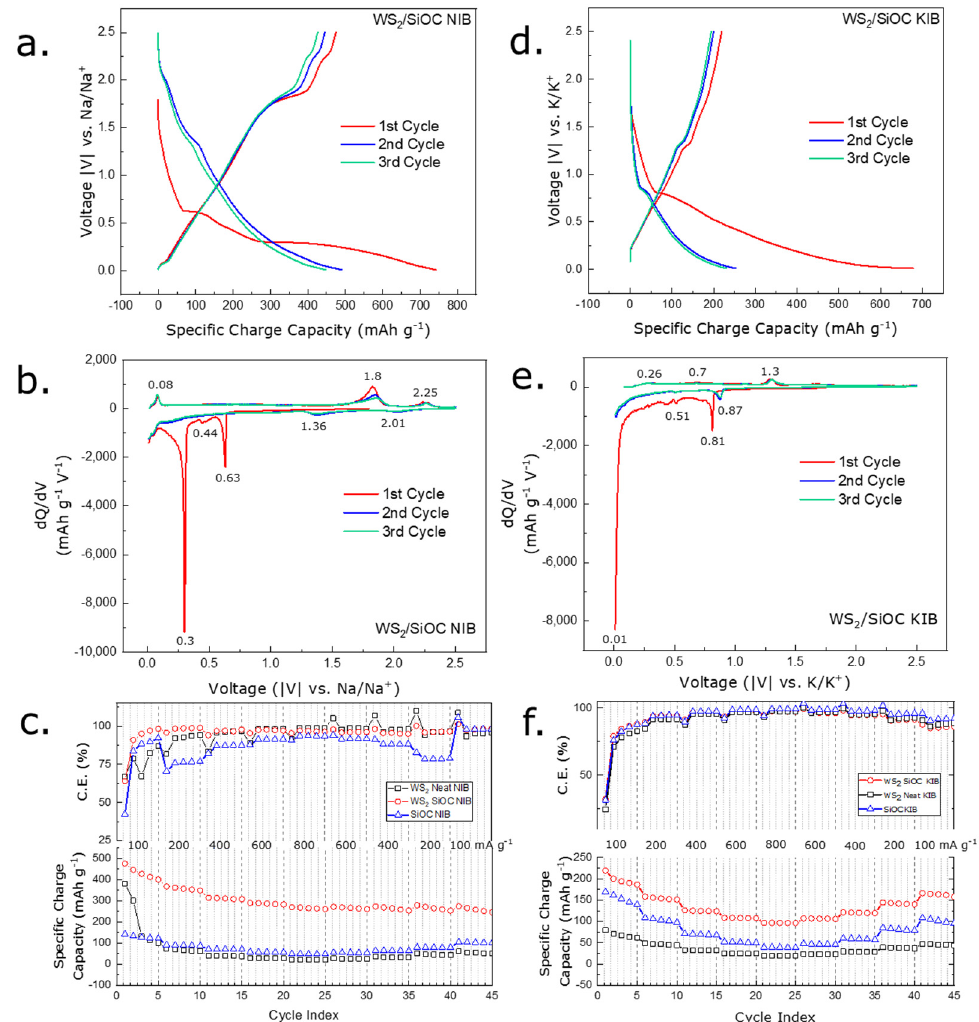
Figure 4. ( a ) GCD profile of the WS 2 /SiOC composite electrode when tested in a Na-ion half-cell setup; ( b ) differential capacity curve of the WS 2 /SiOC composite electrode in Na-ion half-cell setup derived from the GCD profile; ( c ) Rate capability test performed for the WS 2 /SiOC electrode when tested in a Na-ion half-cell setup at increasing current densities and bringing back to initial conditions after five cycles after each step; ( d ) GCD profile of the WS 2 /SiOC composite electrode when tested in a K-ion half-cell setup; ( e ) differential capacity curve of the WS 2 /SiOC composite electrode in K-ion half-cell setup derived from the GCD profile; ( f ) Rate capability test performed for the WS 2 /SiOC electrode when tested in a K + ion half-cell setup at increasing current densities and bringing back to initial conditions after five cycles after each step.